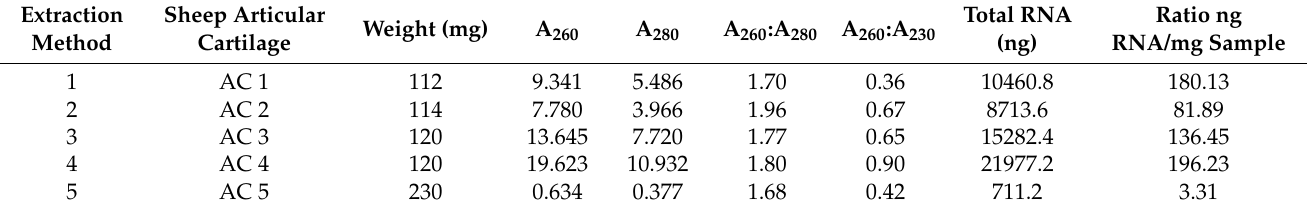
Table 6. Weight, concentration, purity, and integrity of RNA isolated from sheep articular cartilage using different